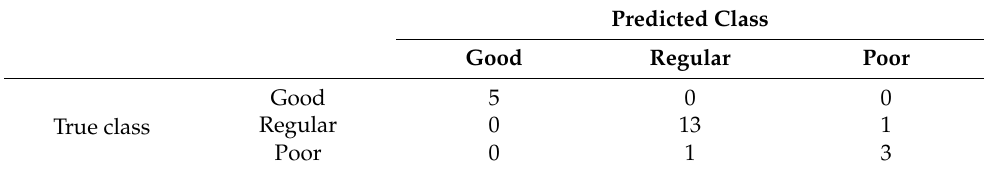
Table 12. Confusion matrix of the proposed meta-learning for the 3-NN classifier.